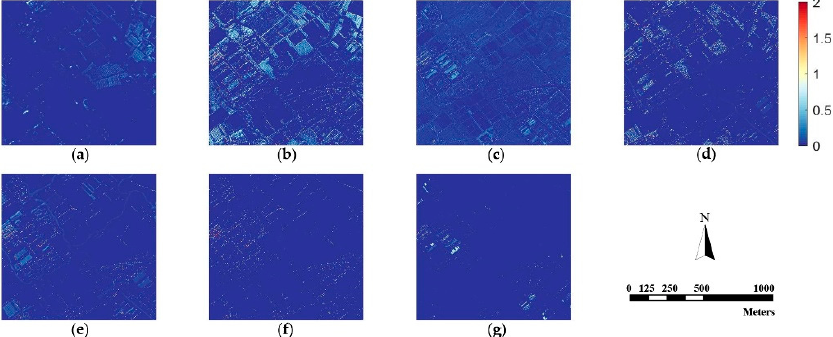
Figure 8. The difference image between the fused images and the referenced MS image for Triplesat data. ( a ) GS ( b ) AIHS; ( c ) WT-SR; ( d ) WT-IHS; ( e ) CT-ICA; ( f ) CSI; ( g ) proposed.